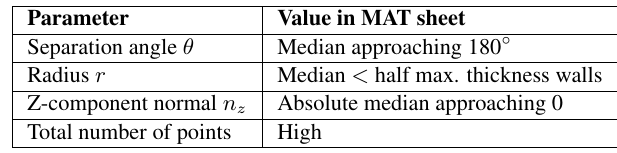
Figure 5. Overview of the steps in the methodology